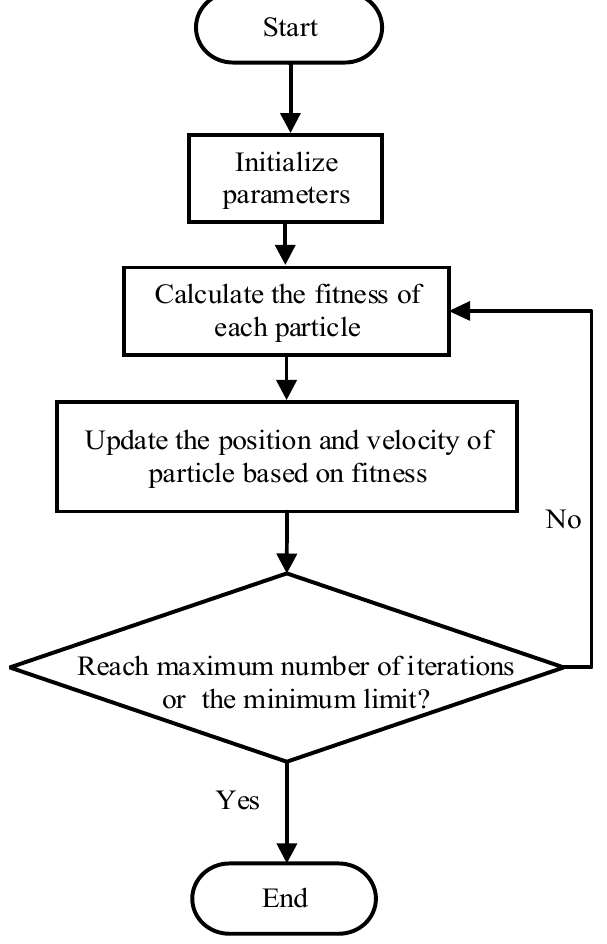
Figure 4. PSO algorithm flowchart.